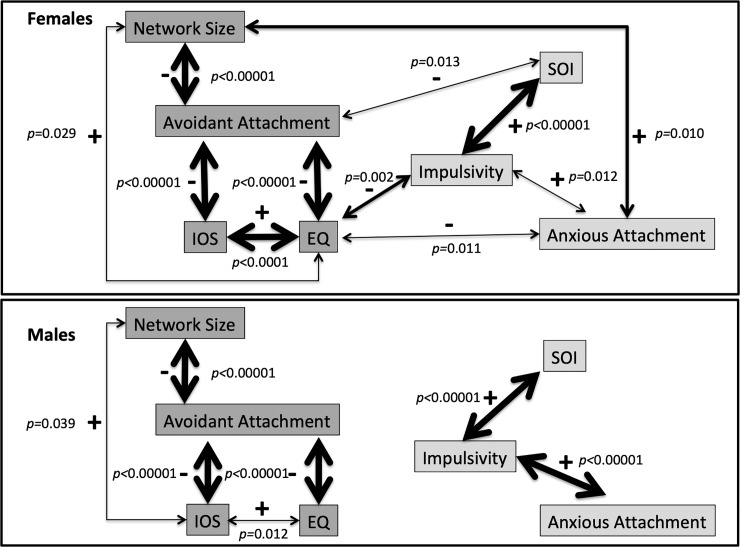
Path analyses between dispositional and social variables in females (top) and males (bottom). The line weights of the arrows represent p-values of p<0.05, p<0.01 and p<0.001: the thicker the line the lower the p-value. The two PCA clusters are shown in different shades of grey. EQ: Empathy Quotient; IOS: Inclusion of Other in Self scale; SOI: Sociosexual Orientation Inventory; Avoidant/Anxious: scores on dimensions of Attachment measured by the Experience in Close Relationships scale.